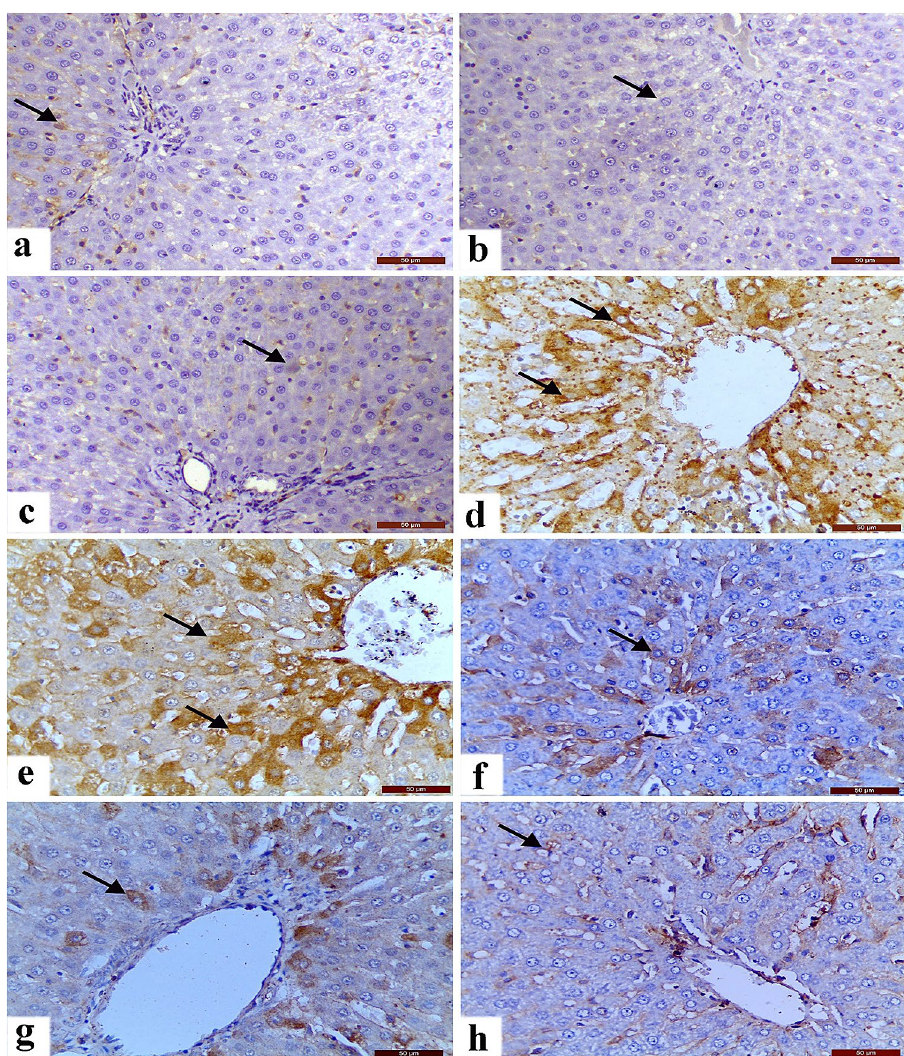
Figure 3. Changes in hepatic caspase-3 expression. ( a )–( c ) showed the negative immunostaining reactions in the Control ( a ), LP ( b ), and NAC ( c ) groups. ( d ) and ( e ) CP-induced changes showing severe immunostaining reaction. ( f ) Caspase staining in the LP + CP group showing moderate immunostaining. ( g ) Caspase staining in the NAC + CP group showing moderate immunostaining. ( h ) Caspase staining in the LP + NAC + CP group showing mild immunostaining. Scale bar = 50